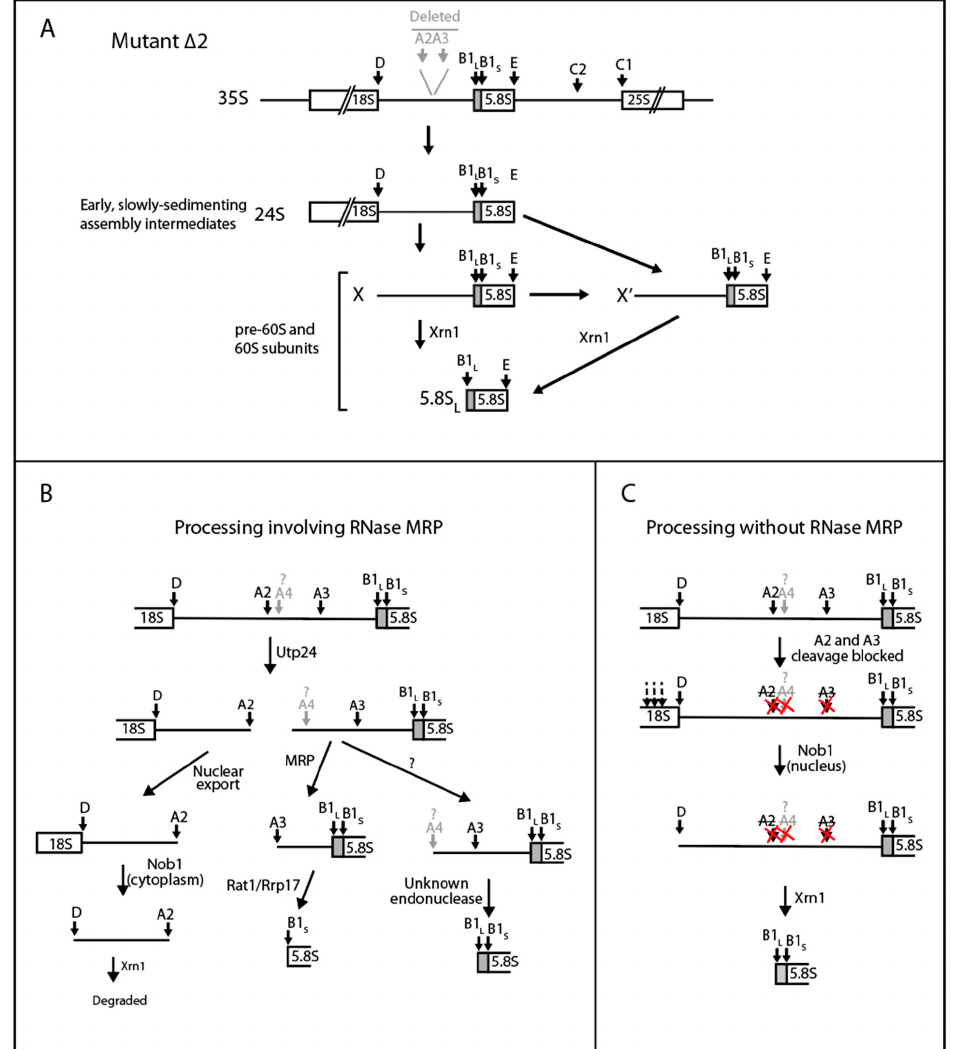
Figure 9. Models for ITS1 processing and switch between processing modes. ( A ) Xrn1-dependent processing of ∆ 2 pre- rRNA. See text for details. ( B ) Processing involving RNase MRP (canonical model). Note that the path to 5.8S L involves an intermediate with a 5 ′ end (A4) a short distance downstream of A2 [25,45]. ( C ) Processing without RNase MRP participation. Inactivation of RNase MRP blocks cleavage at both A2 and A3, allowing Xrn1 exonuclease to degrade the entire region from D to B1 L . We propose that the processing of pre-rRNA occurs via a competition between the pathways in panels B and C, with the canonical model in panel B being dominant during growth under laboratory conditions. If RNase MRP activity is decreased due to change of growth conditions or mutations, the kinetic mix of the models in panels B and C switches in the direction of model C. In the extreme case of total inactivation of RNase MRP, processing occurs exclusively via the model in C.